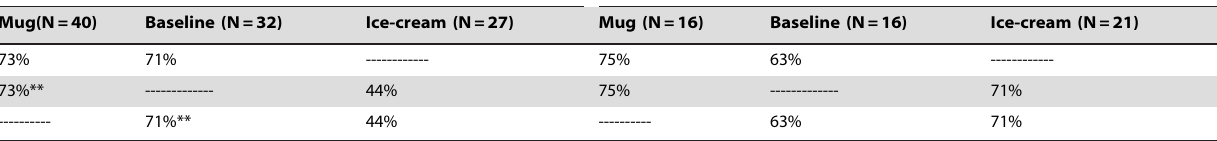
Pairwise Comparison between